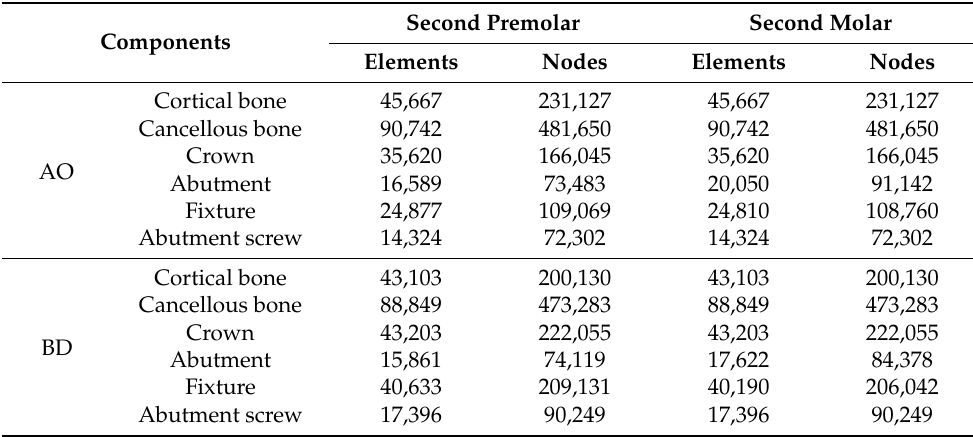
Table 2. Number of elements and nodes for finite element surgical